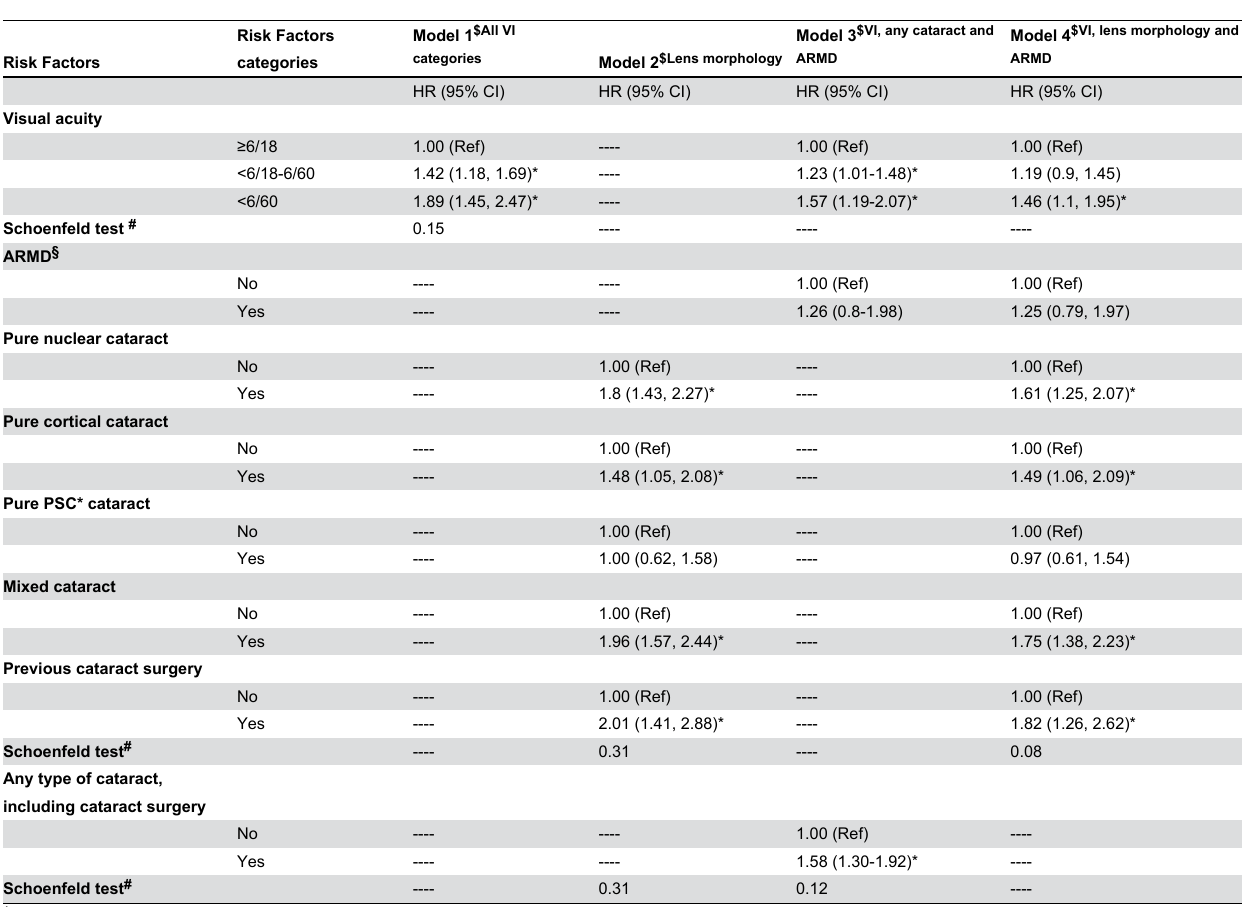
Table 5. Multivariable association of ocular factors with mortality in four different